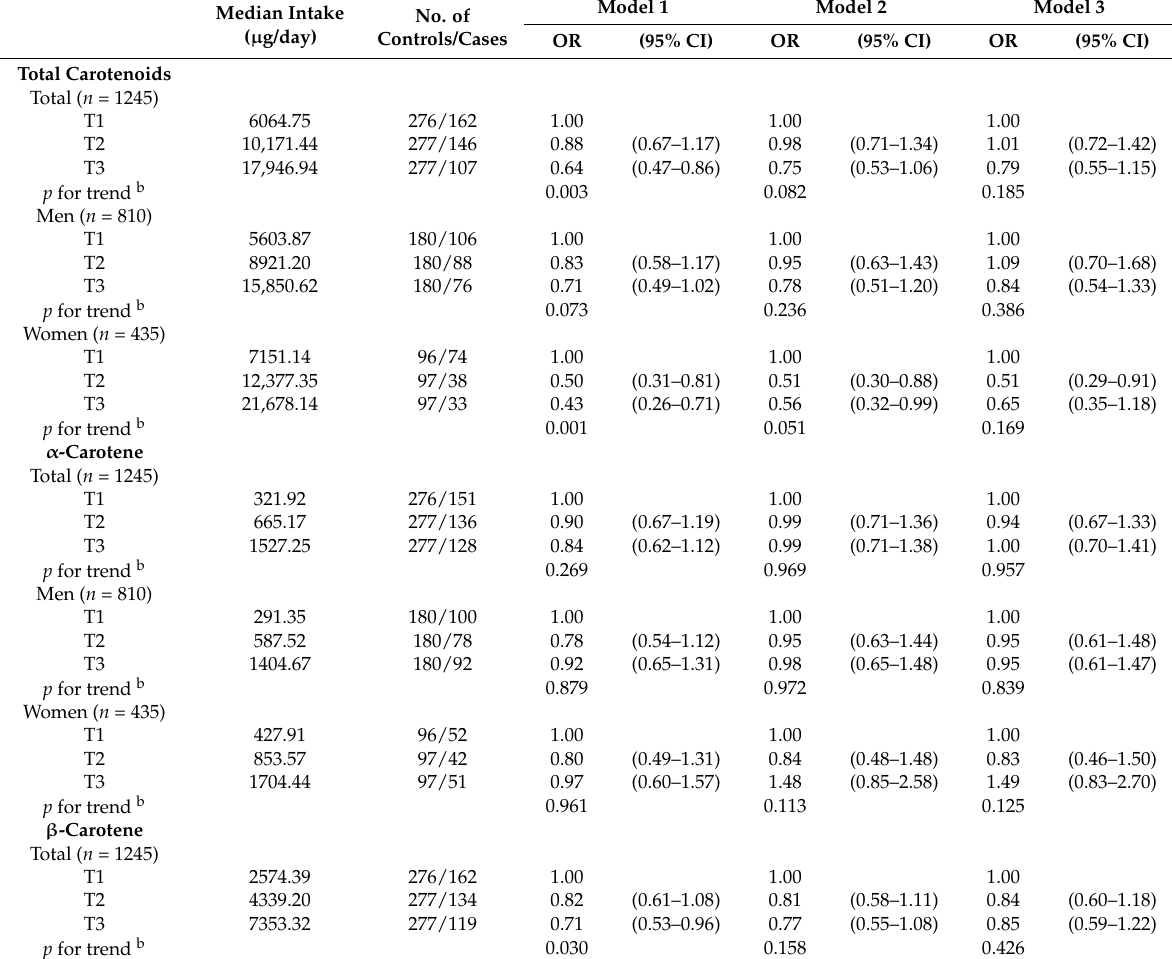
Table 3. Odds ratios (ORs) and 95% confidence intervals (CIs) of gastric cancer (GC) according to the tertiles of total dietary carotenoids and carotenoid subclasses a